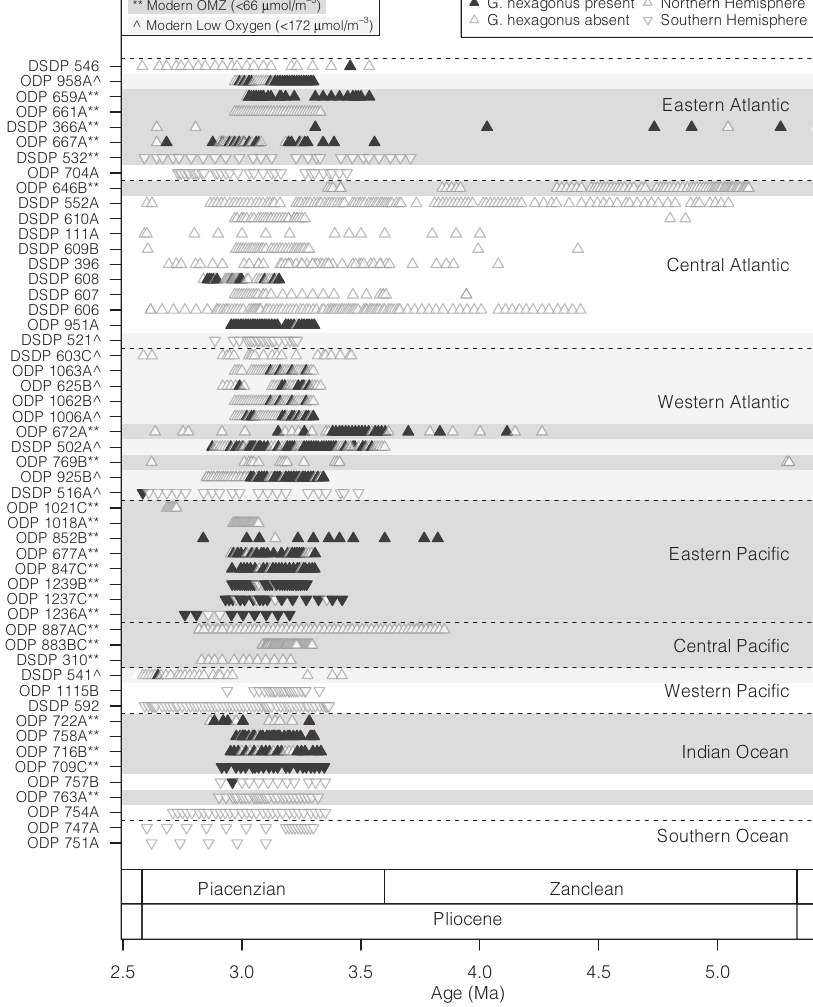
oxygen<66 µ molm − 3 .Thosewithalightgrayboxandlabeledwitha ‘ ^ ’ inthelegend areregionswhichmeetourlow-oxygenthreshold(<172 μ molm − 3 ;Fig.1)butarenot consistently understood to be within permanent modern OMZ. Upward-facing triangles are from sites in the northern hemisphere, while downward-facing trian- gles indicate sites in the southern